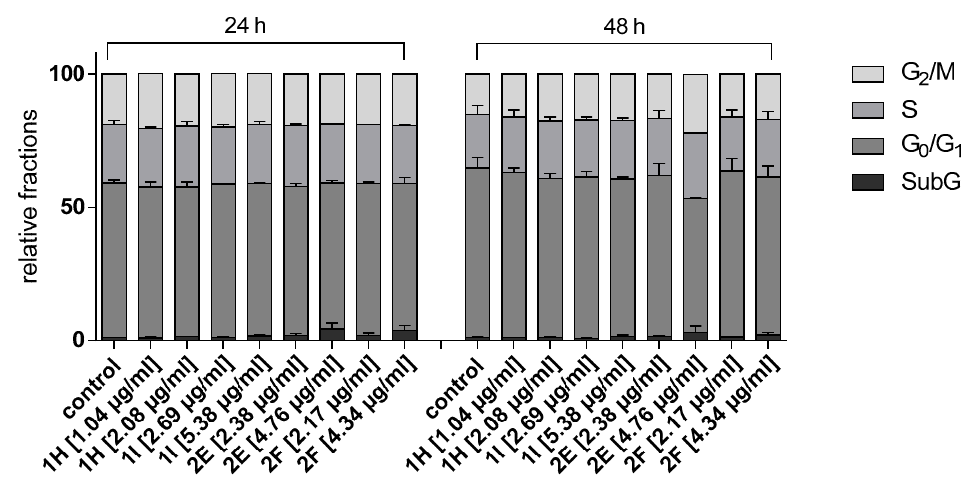
Figure 5. Effect of column chromatography fractions 1H, 1I 2E, 2F on cell cycle in SiSo cancer cell line.